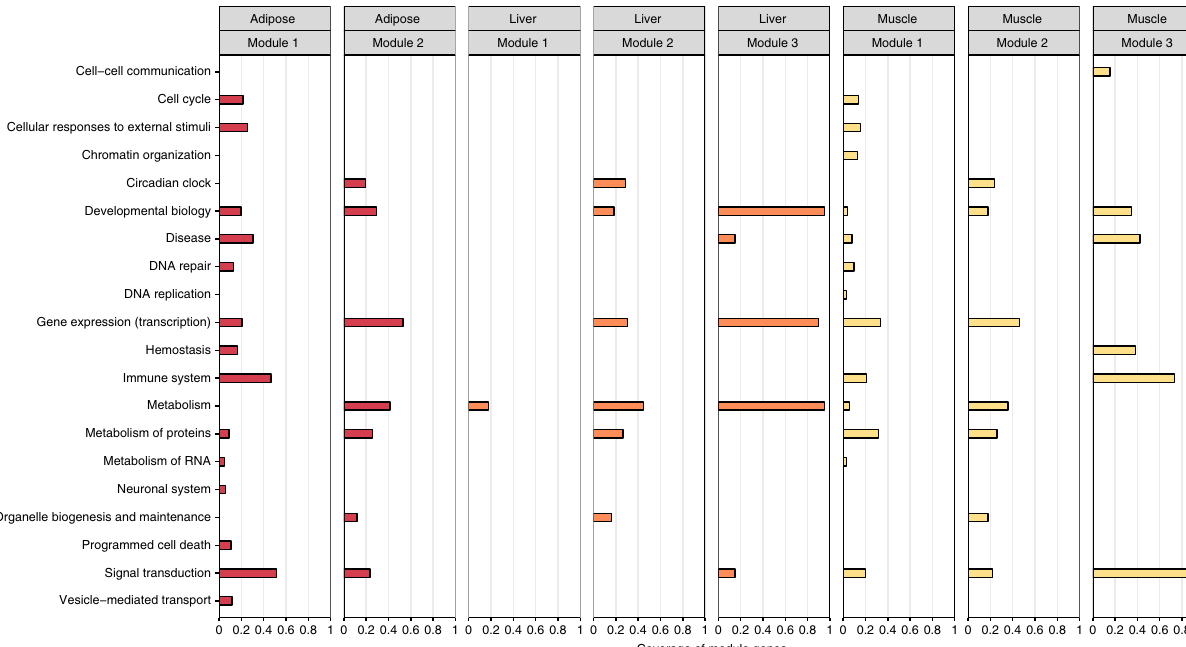
Fig. 4 Functional annotation of the disease modules. For each network and disease module the coverage of module genes by signi fi cantly enriched Reactome pathways, grouped according to the TopLevel pathway classi fi cation, is presented. See also Supplementary Data